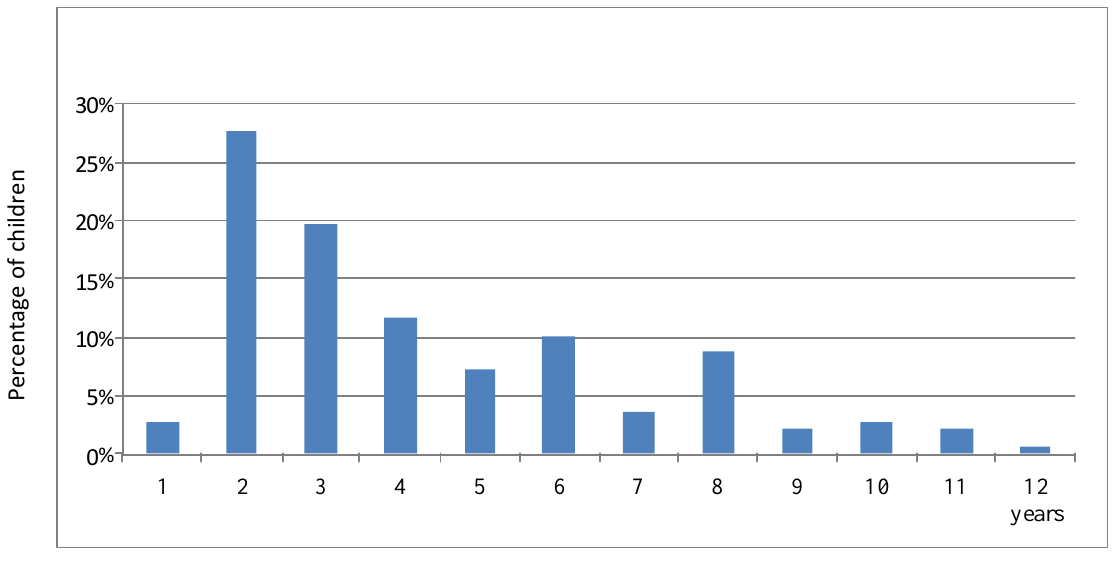
Figure 1. Age at presentation to the child mental health